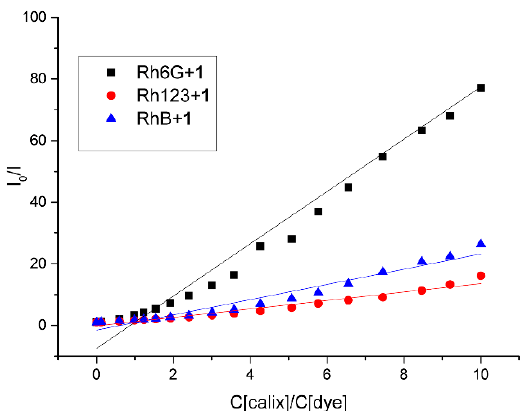
Figure 5. Stern-Volmer plots for rhodamine dyes with macrocycle 1 at pH 4.5. C (dye) = 1 μ M, acetate buffer (pH 4.5). Table 2. a Association constants (K a ) of calixarene 1 complexes with rhodamine dyes at pH 4.5. System